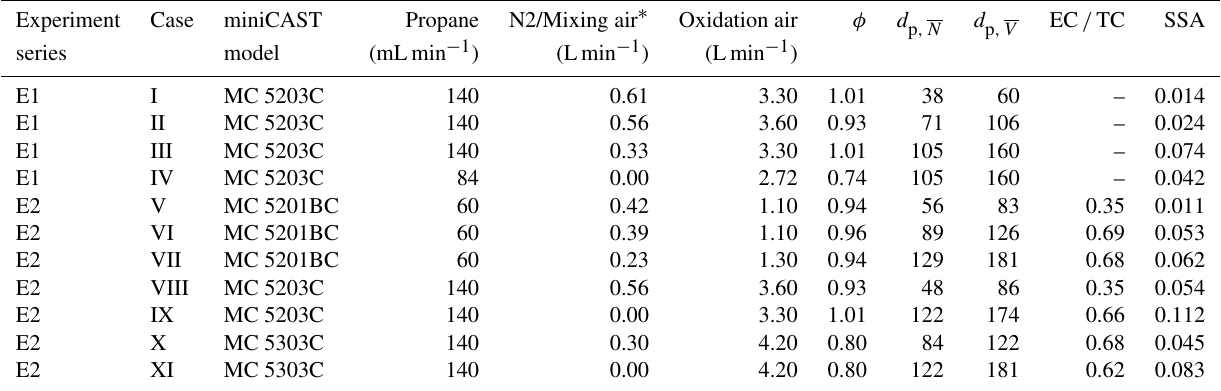
Table 1. Details of the different cases in experiments E1 and E2 – the operating conditions and resulting properties of the particles, such as the mobility diameters ( d and d ), ratio of the elemental to total carbon (EC / TC), and single-scattering albedo (SSA) at wavelength p ,N p ,V of 660nm. All the mentioned properties will be defined in the next